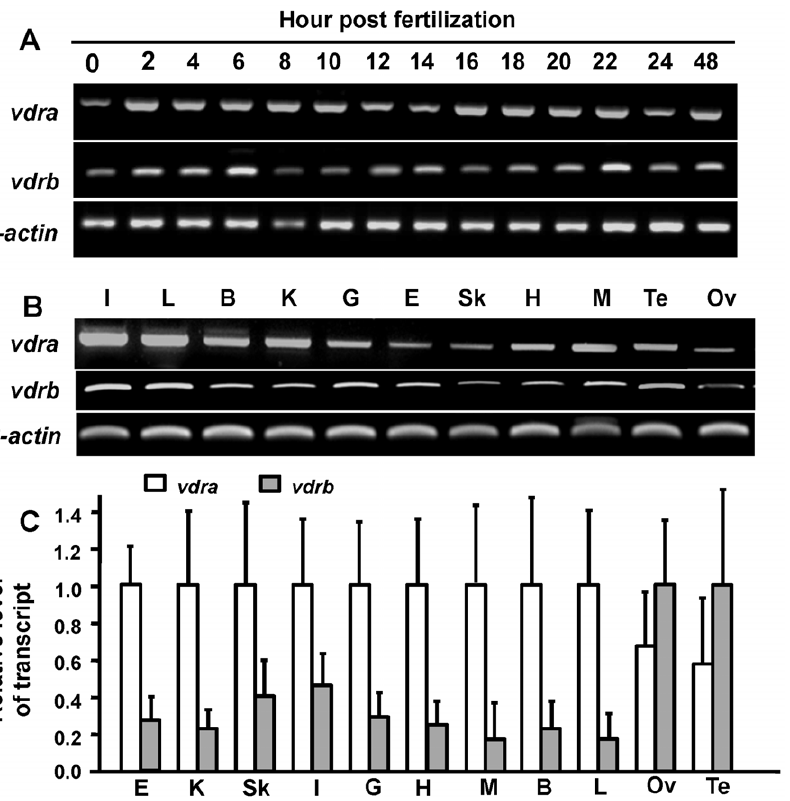
Figure 4. Zebrafish vdra and vdrb expression profiles. mRNA expression patterns in developing stages (A) and various tissues (B) were determined by an RT-PCR using b -actin as the internal control. (C) vdra and vdrb mRNA expressions in different tissues of adult zebrafish were analyzed by a qPCR using b -actin as the internal control. Values are the mean 6 SD ( n =3). E, eye; K, kidney; Sk, skin; I, intestine; G, gill; H, heart; M, muscle; B, brain; L, liver; Ov, ovary; Te, testis.